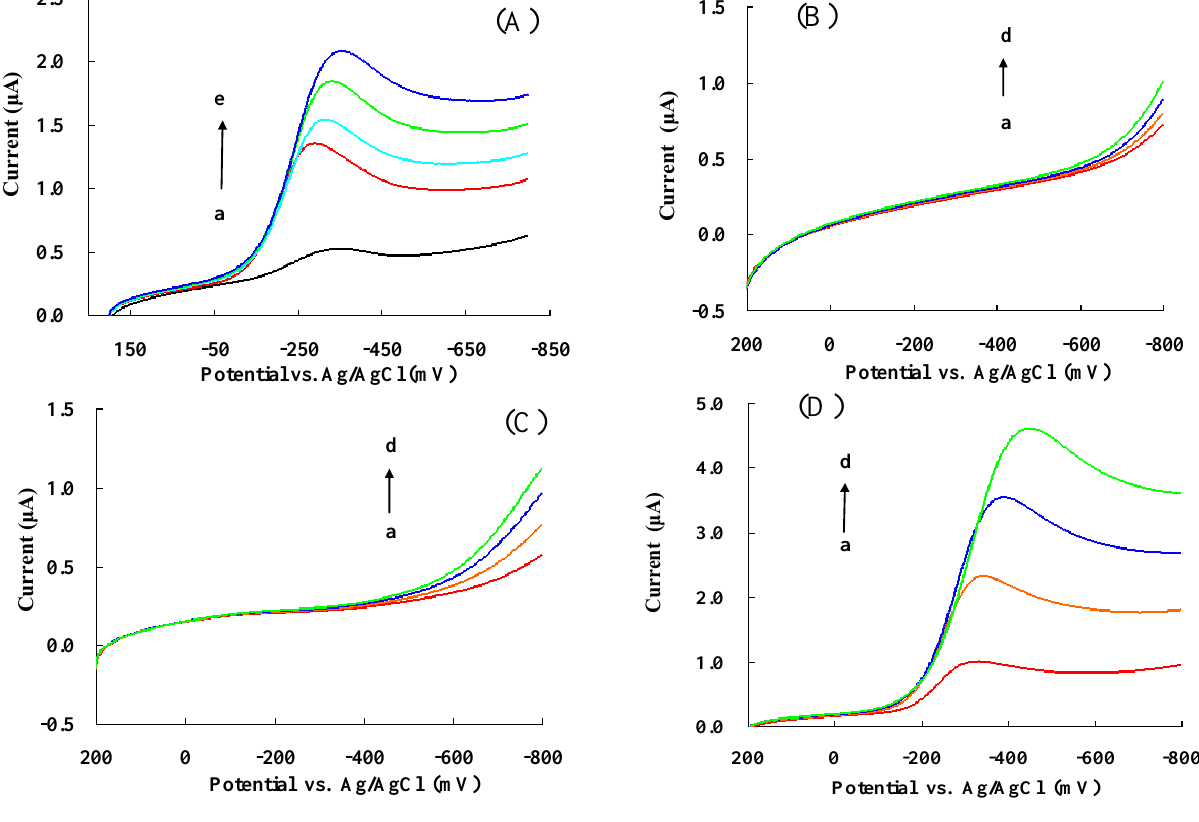
Figure 4. LSVs of ( A ) NF/Hb/FMWCNTs/Cys/AuNPs/GC electrode in the absence or presence of different concentrations of H 0.20 mM, respectively. LSVs of ( B ) Cys/AuNPs/GC; ( C ) NF/Cys/AuNPs/GC and ( D ) NF/Hb/Cys/AuNPs/GC electrodes, respectively in the presence of different concentrations of H O (from a to curve d): 0.1, 0.3, 0.5 and 0.7 mM, 2 2